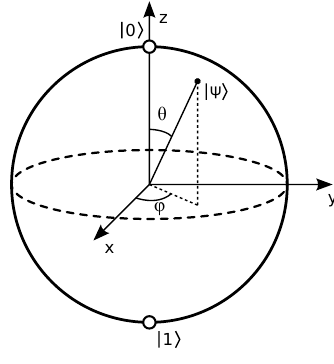
Figure 10. The Bloch